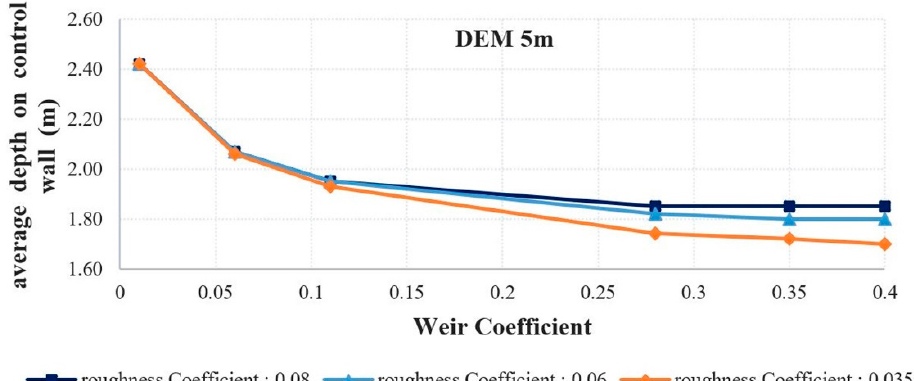
Figure 4. Simulated depth on control wall for varying Weir coefficient in the lateral structures and Manning’s roughness coefficient n f in the flow areas, through the coupled hydraulic 1D/2D HEC-RAS (Hydrologic Engineering Center’s River Analysis System) model, at high-resolution DEM 5 m × 5 m.